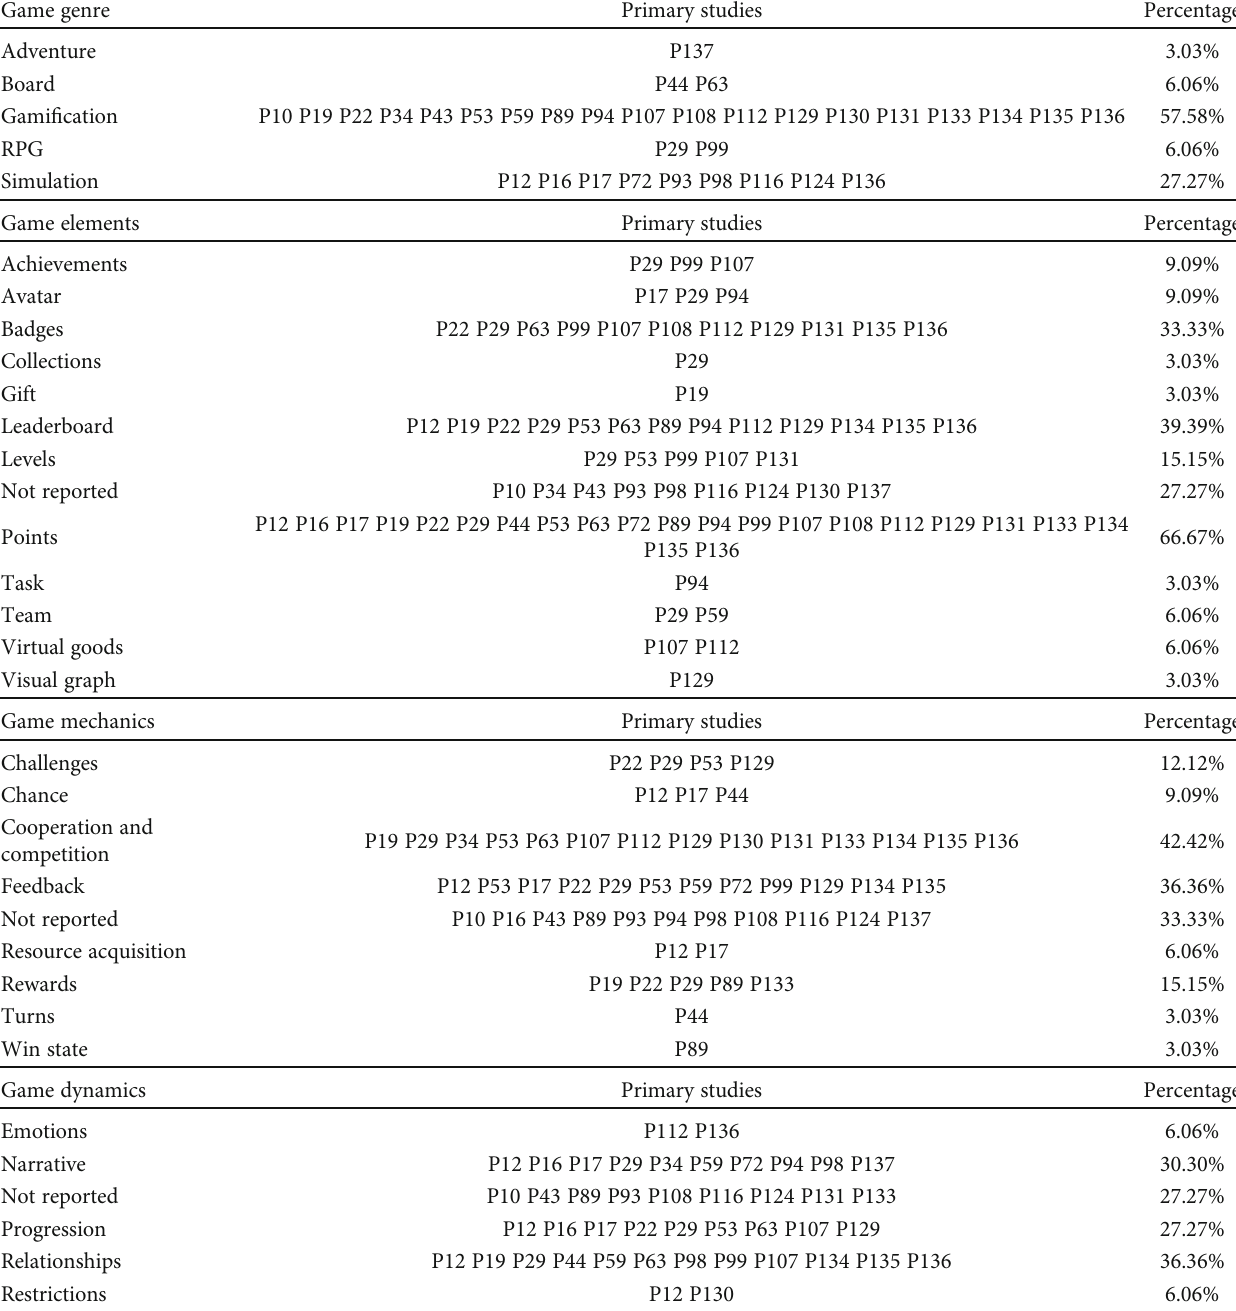
Table 18: Game elements identi fi ed in the primary software measurement